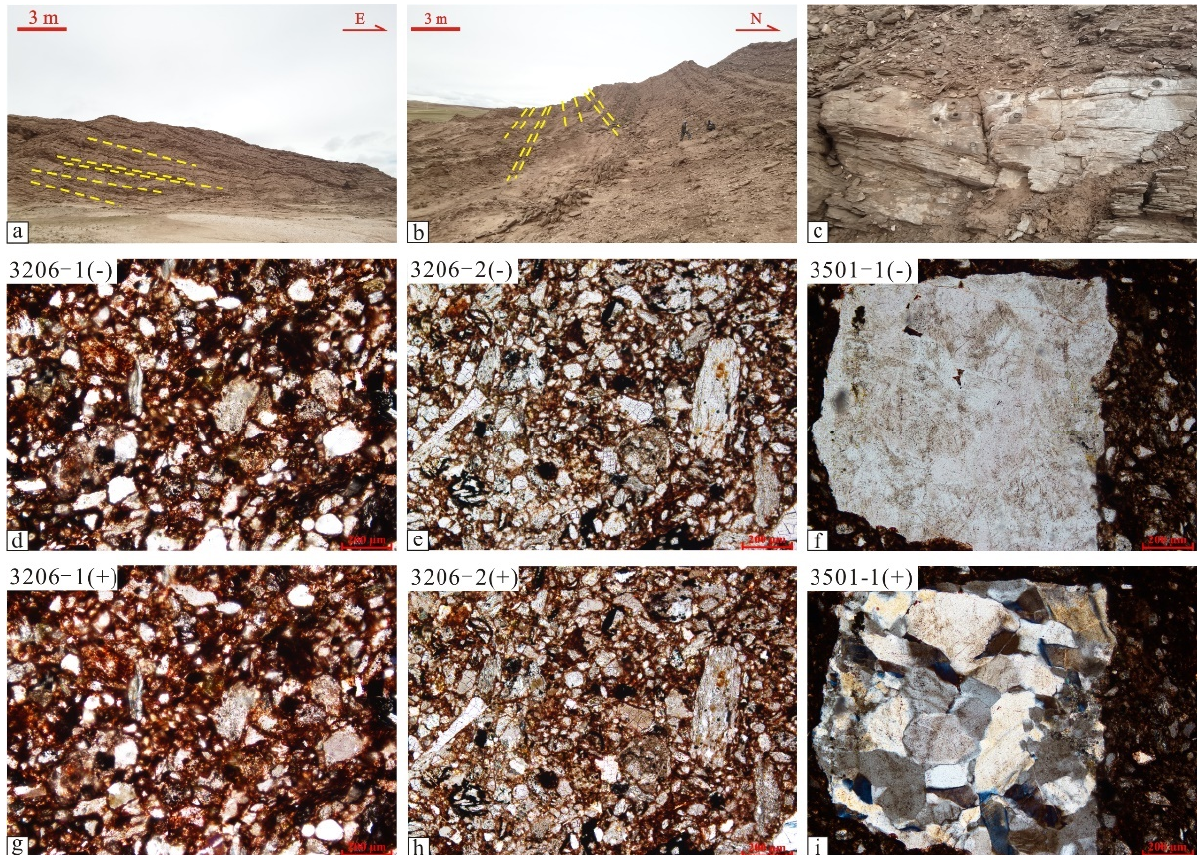
Figure 3. The photo of sandstone minerals and field outcrops in the Jingzhushan Formation on the west side of Nyima County. ( a , b ) Occurrence of field profile; ( c ) Outcrops and drilling conditions; ( d – f ) Minerals photos under the polarising microscope; ( g – i ) Minerals photos under the orthogonal microscope.